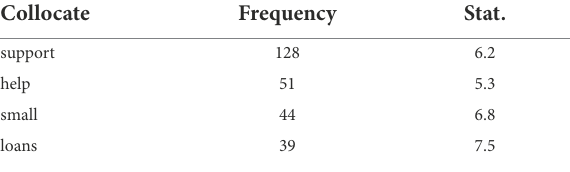
TABLE 6 Top six most frequent collocates of ‘partners’. TABLE 7 Top four frequent collocates that predicate